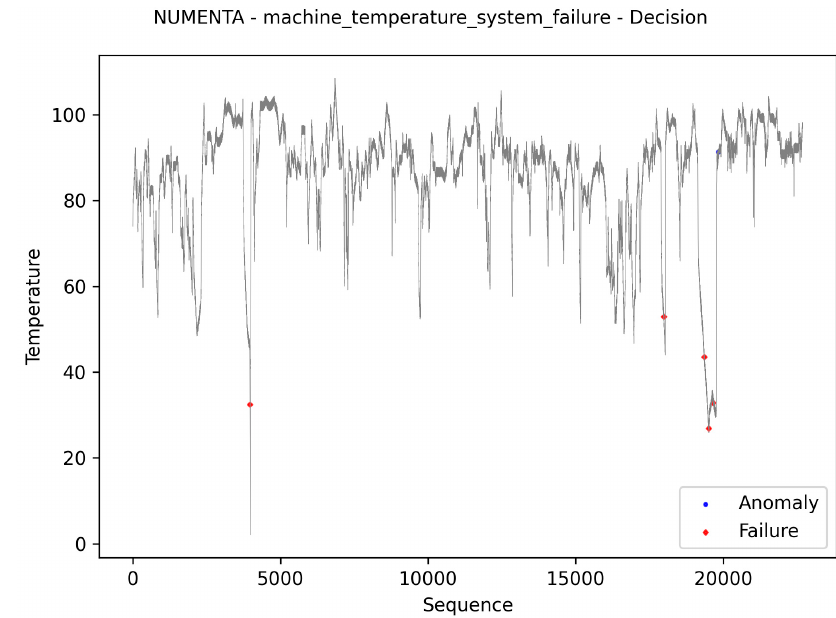
Figure 13. Intel dataset: matrix profile results.